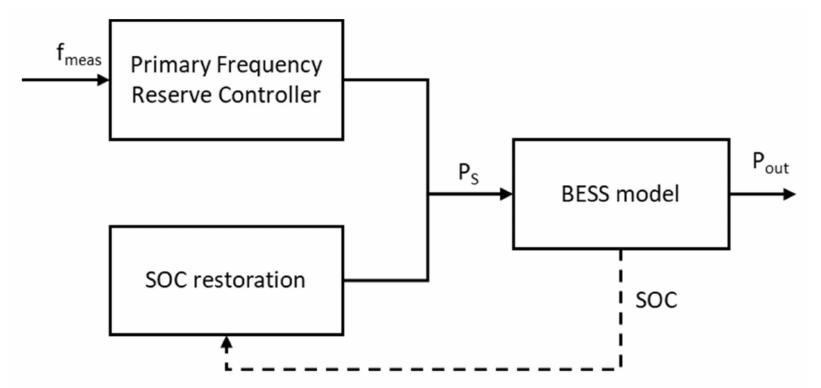
Figure 7. The open-loop simulation of the WAPPITS system (in Simulink).